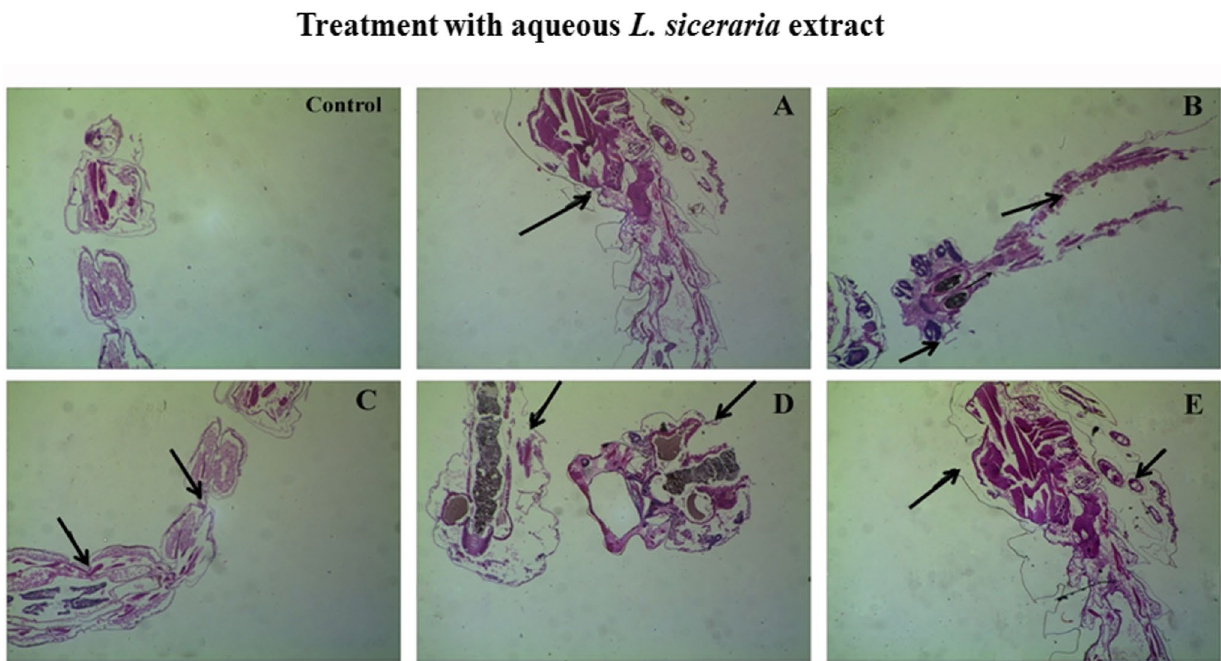
Figure 1. Histopathological images of third instar larvae of An. Stephensi treated with: ( A ) 80 ppm of L. siceraria aqueous extract. ( B ) 160 ppm L. siceraria aqueous extract; ( C ) 240 ppm of L. siceraria aqueous extract; ( D ) 320 ppm of L. siceraria aqueous extract; ( E ) 400 ppm L. siceraria aqueous extract (Arrow indicates disordered and broken epithelial cell, complete break up of midgut and caeca and collapsed larval structure).